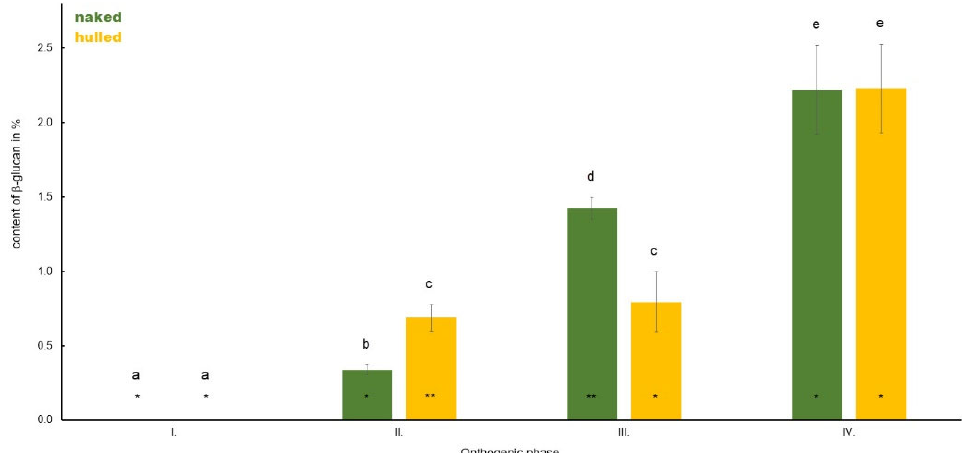
Figure 8. Comparison of the content of β‐ D ‐ glucan in the panicle of hulled and naked oat samples during plant ontogenesis. Different letters indicate a statistically significant difference between individual seed types (naked and hull) in specific ontogenetic phase evaluated by ANOVA (LSD, p ≤ 0.05). Star symbols (* and **) represent statistically significant difference between naked and hulled samples evaluated for each ontogenetic phase individually by ANOVA (LSD, p ≤ 0.05).